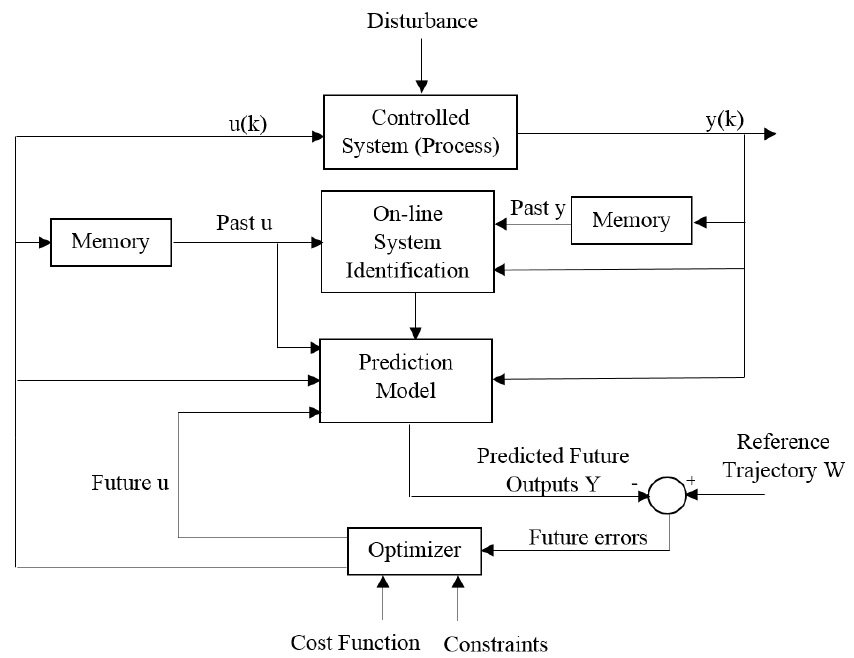
Figure 10. GA for PI controller tuning.